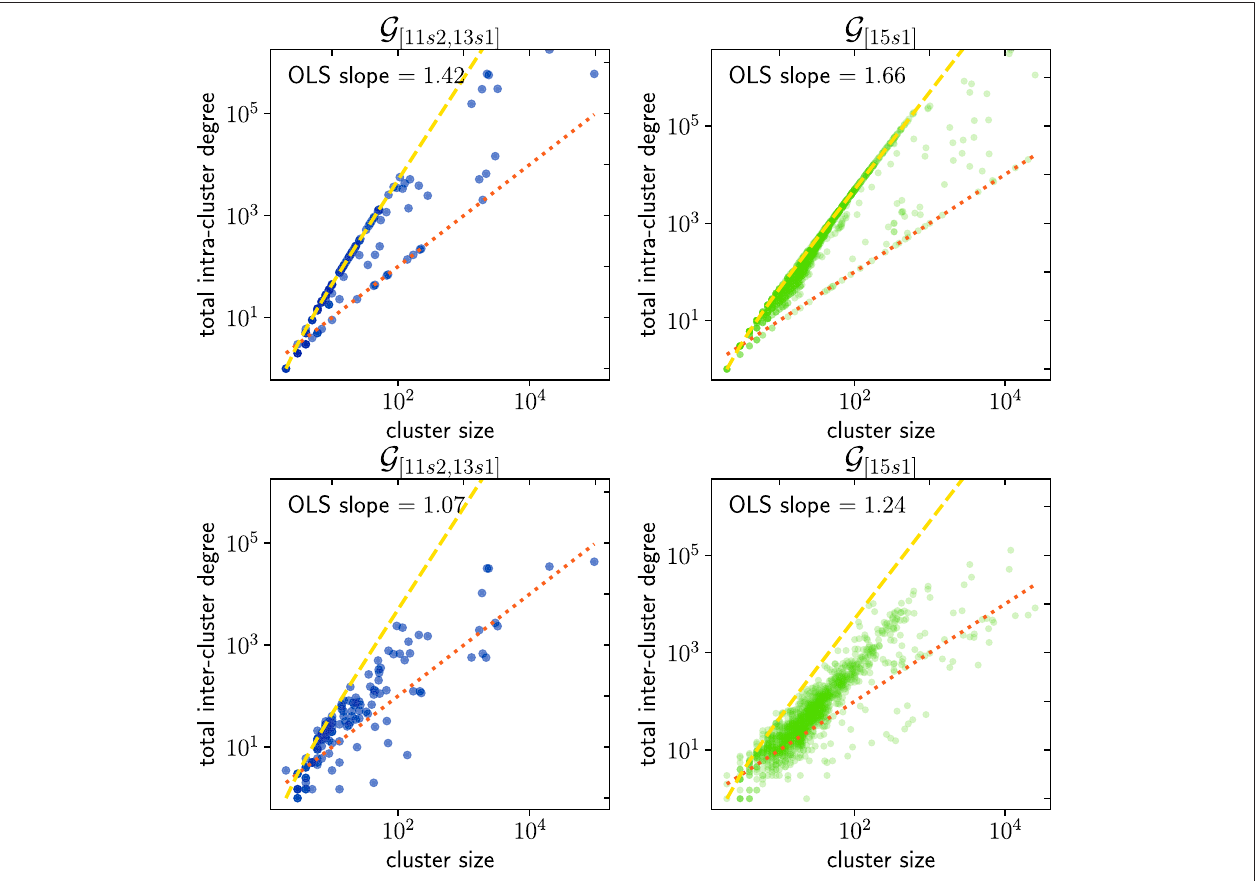
FIGURE 7 | Comparison of the total intra-cluster and inter-cluster degrees for G [ 11s2 , 13s1 ] and G [ 15s1 ] . We also show the lines y (cid:2) x (red, dotted) and y (cid:2) x ( x − 1 ) / 2 (yellow, dashed).